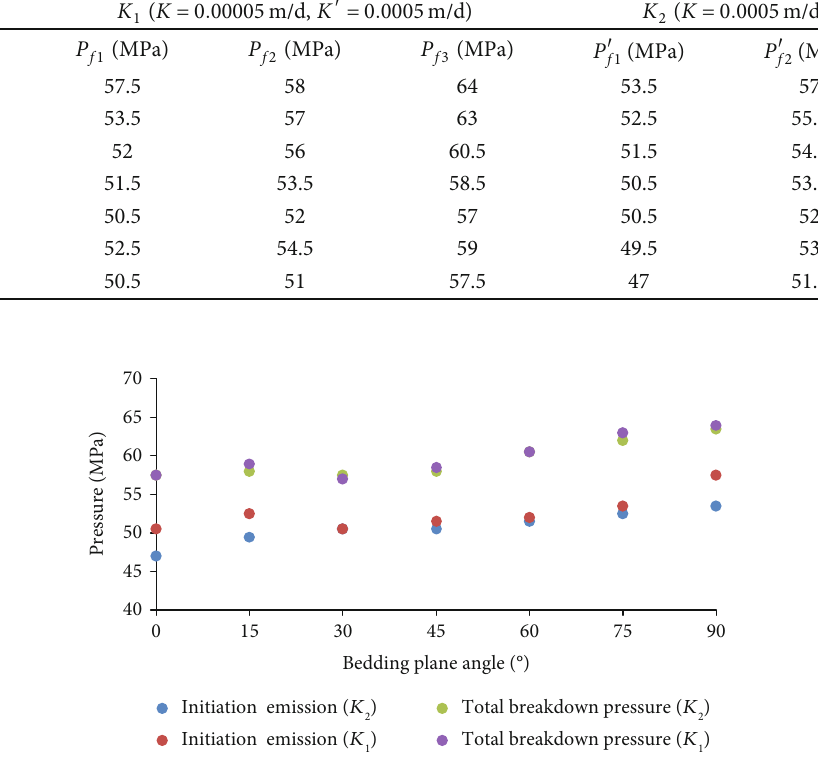
Table 3: Initiation pressure and total break pressure with di ff erent permeability coe ffi cients. Reduction ratio